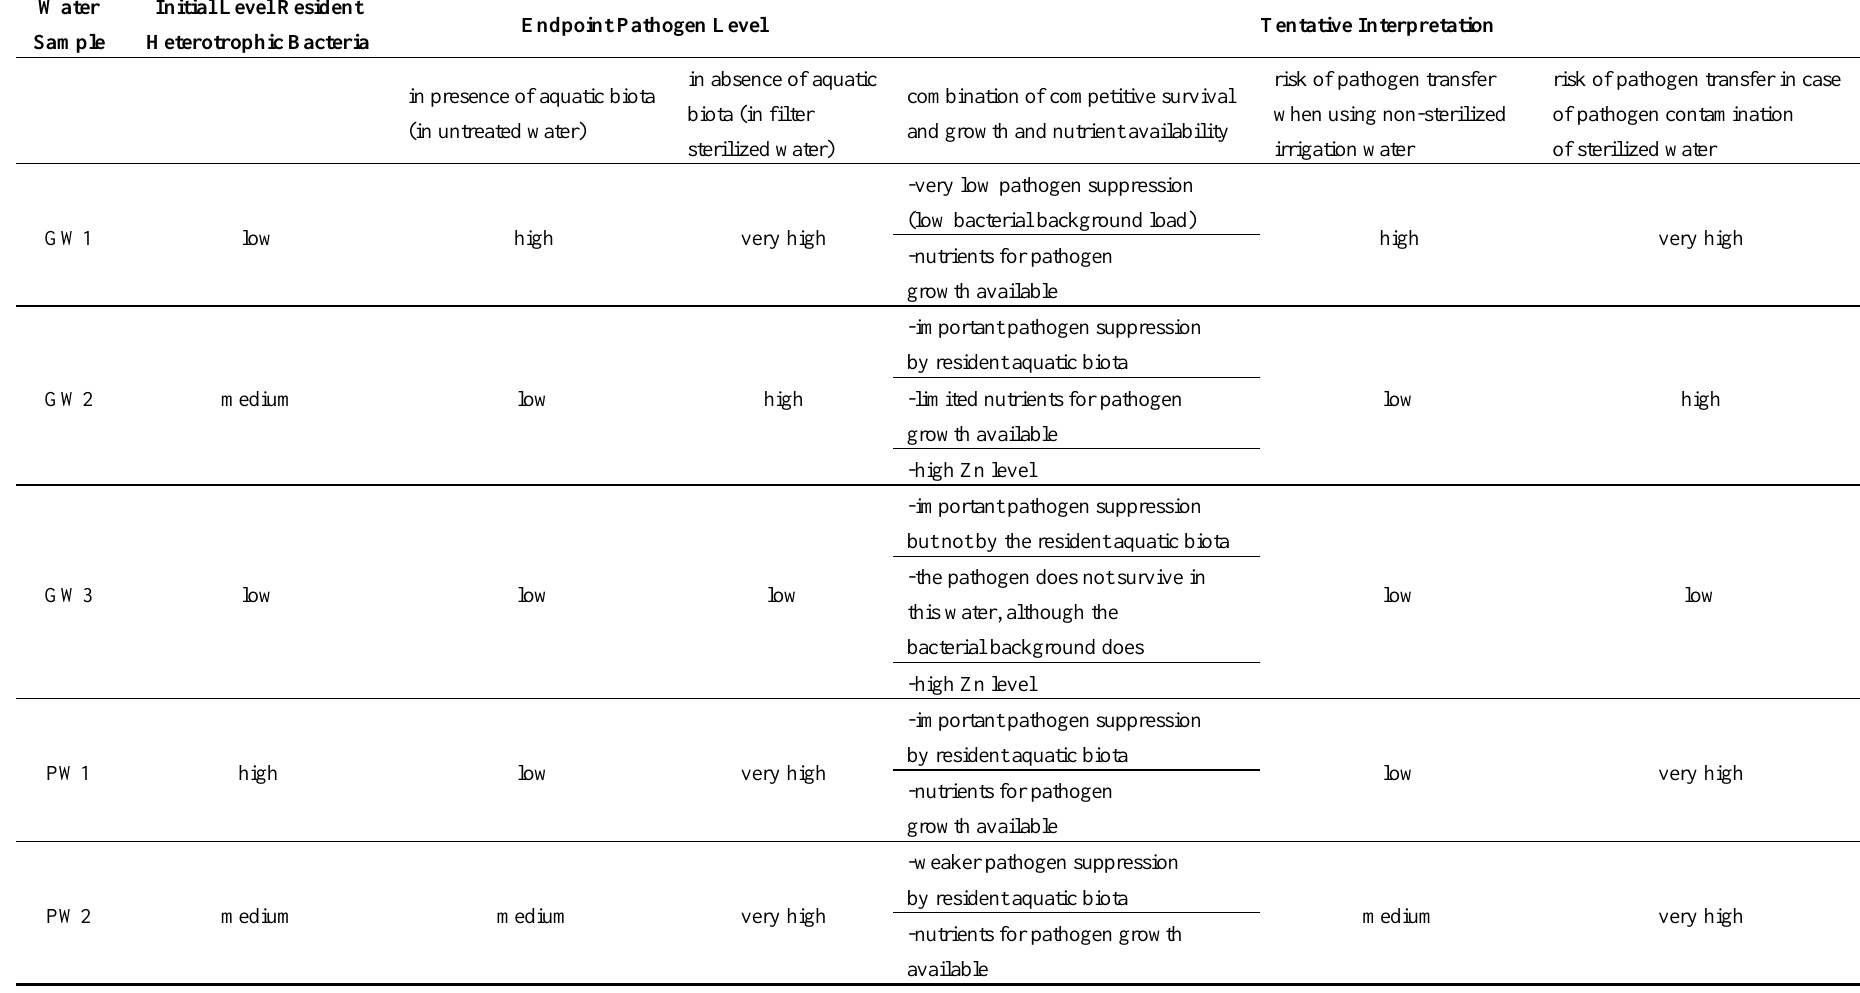
Table 3. Schematic overview of the results of survival of Salmonella and E. coli O157:H7 in 5 irrigation water samples which were previously filter sterilized or not and subsequently stored at 20